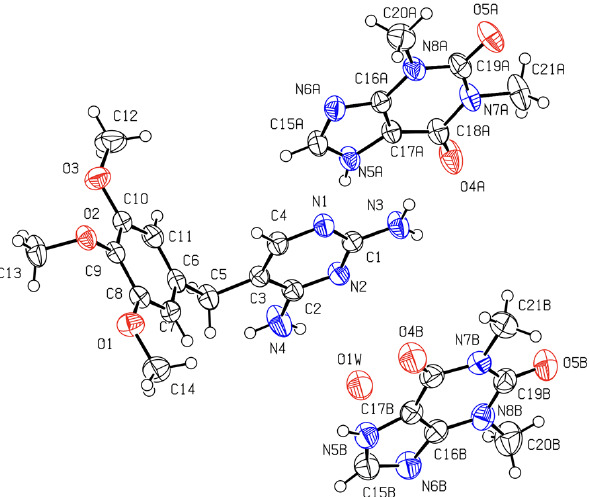
Figure 16. ORTEP diagram of the (1:2) trimethoprim:theophylline, CCDC 2109486. Ellipsoids are drawn at the 50% probability level. Hydrogen atoms are drawn as spheres of arbitrary radius.